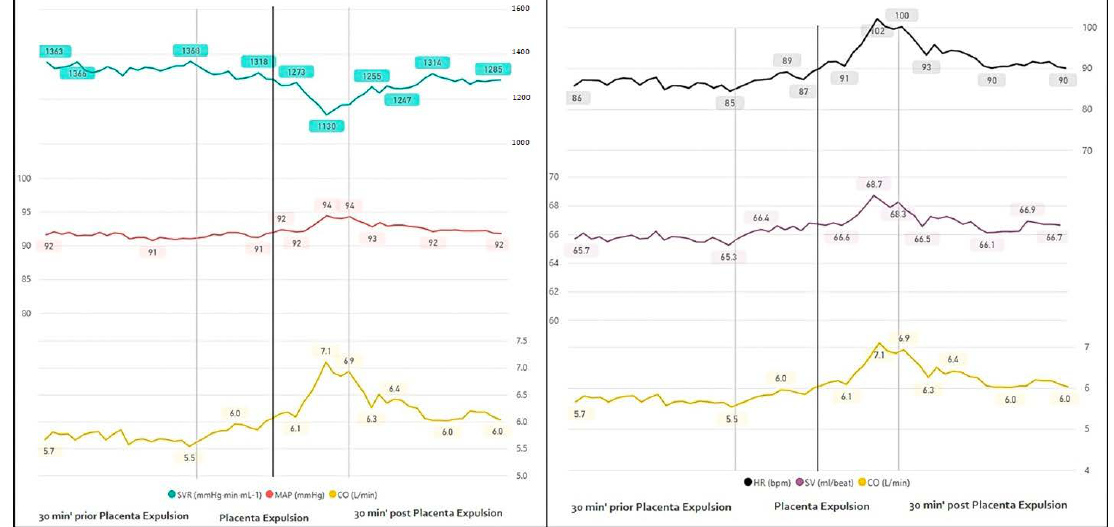
Figure 5. Continuous monitoring 30 min before and after placental expulsion.